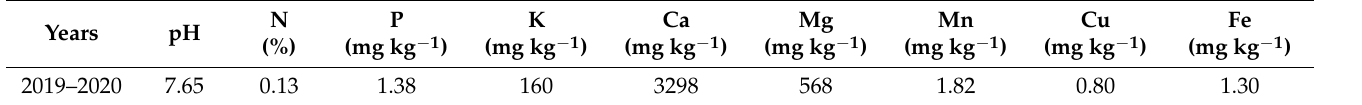
Table 1. Micro and macronutrient analysis of the soil in the research area.